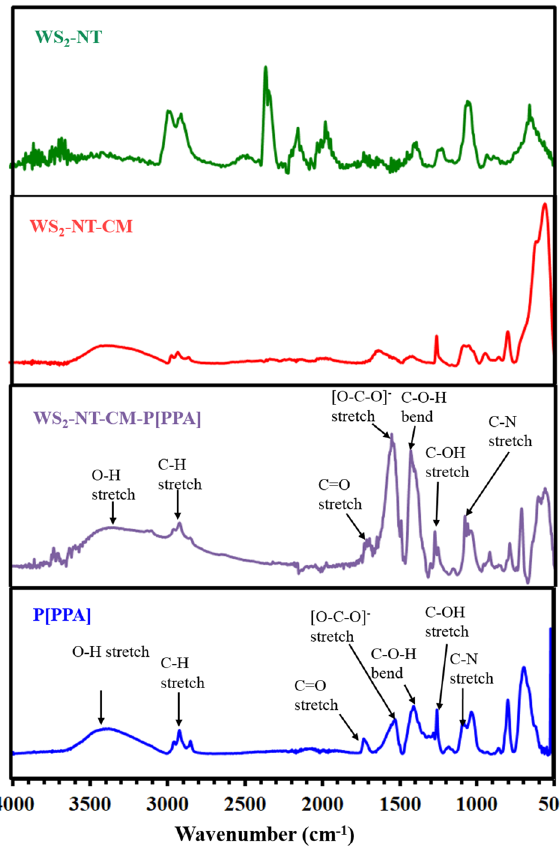
Figure 5. FTIR absorbance spectra of WS 2 -NT, its nanocomposites, and polyPPA